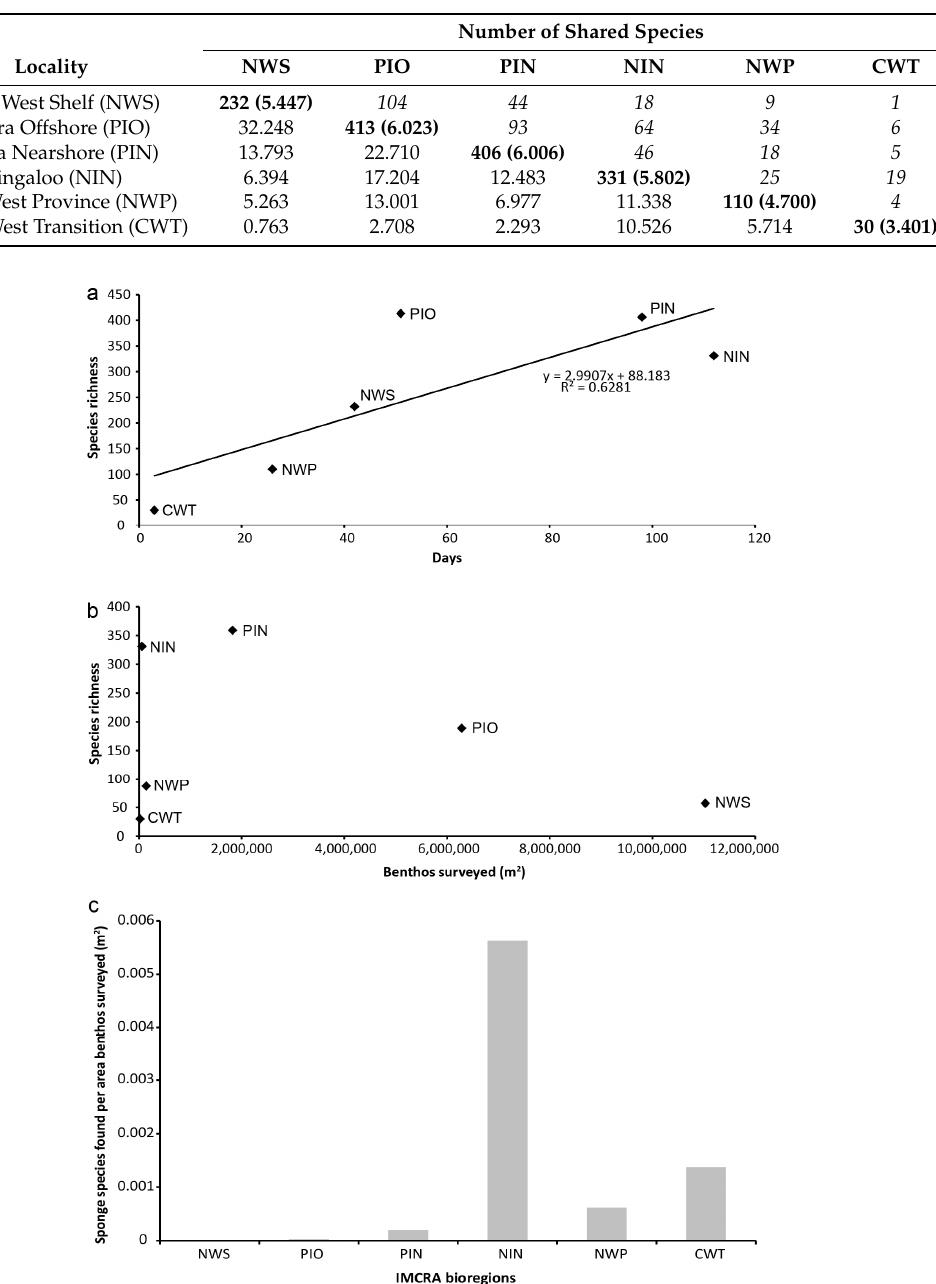
Table 2. Pairwise comparisons of sponge species composition between the six IMCRA bioregions. The upper half of the matrix represents frequencies of co-occurring species between bioregions (in italics). The lower half of the matrix represents percentage similarity of sponge compositions between bioregions based on the Jaccard similarity index (%). Bold text represents the species richness at each bioregion and bold text in parentheses represents corresponding Shannon-Wiener index values. Total described sponge species and OTUs = 1164.